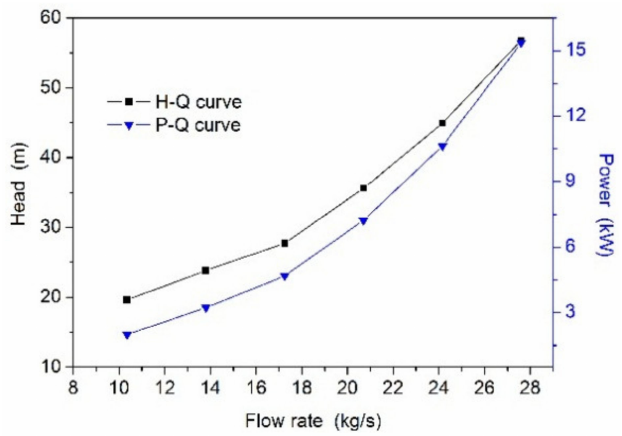
Figure 12. PAT hydraulic performance in terms of head and